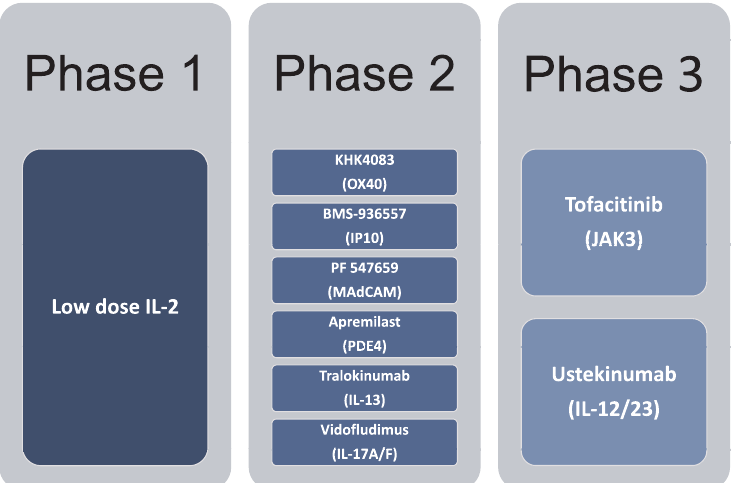
Figure 2. New therapeutic agents for ulcerative colitis. New therapeutic agents for ulcerative colitis with drug targets in parenthesis 47,83–90